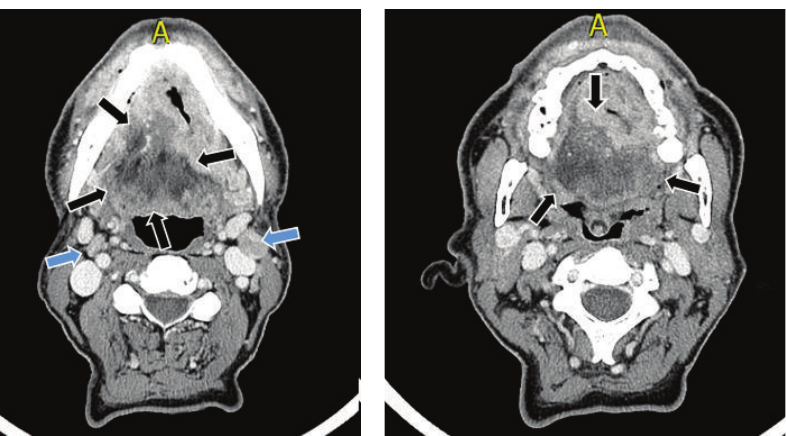
Figure 2: Computed tomography (CT) finding of case one showed that a heterogeneous mass can be seen which spreads to the back of the tongue with extension to the floor of the mouth without reaching the sublingual space (black arrows). The CT confirmed the existence of metastatic lymph nodes (blue